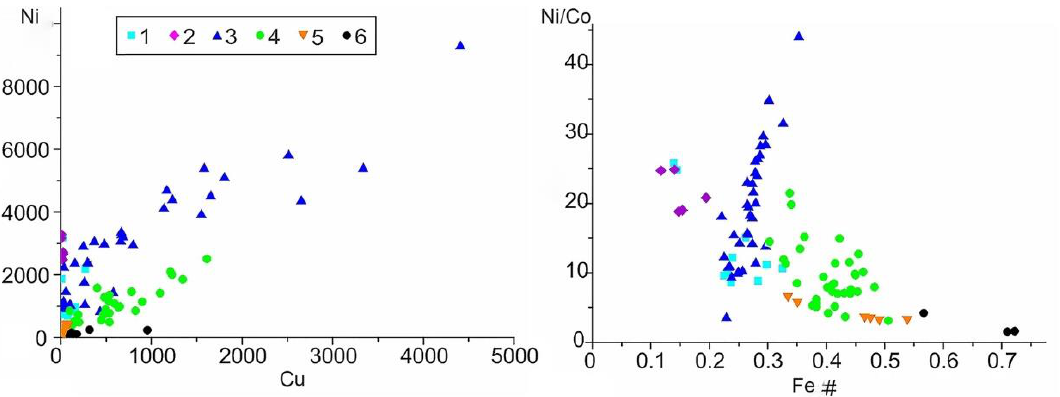
Figure 10. Variations in Ni–Cu and Ni/Co–Fe# ratios in the Monchepluton rocks. 1: I megacycle rocks (NKT); 2: II megacycle rocks (the Dunite Block); 3: III megacycle rocks (Mt. Sopcha); 4: IV megacycle rocks (Mt. Nyud); 5: V megacycle rocks (Mt. Vurechuaivench); 6: Metagabbro of the “10th Anomaly”.